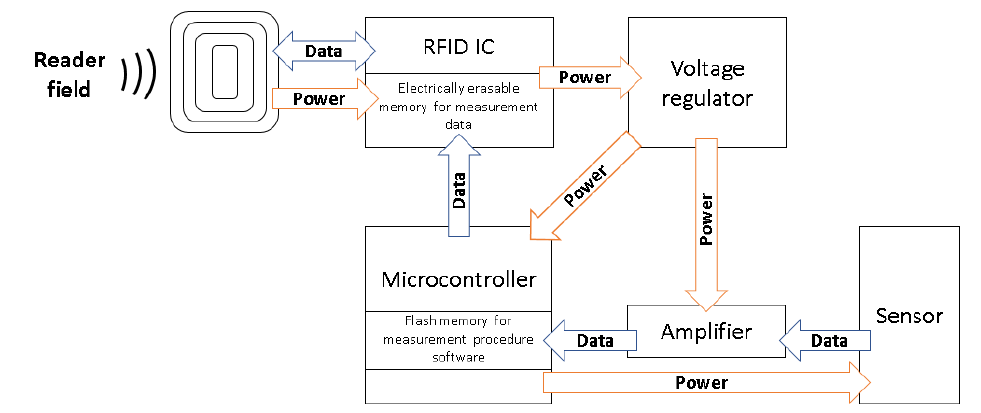
Figure 2. Functional block overview of the sensor